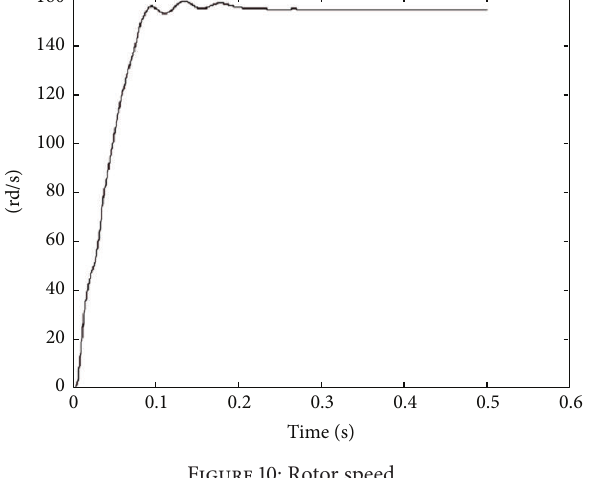
Figure 13: Real rotor speed.